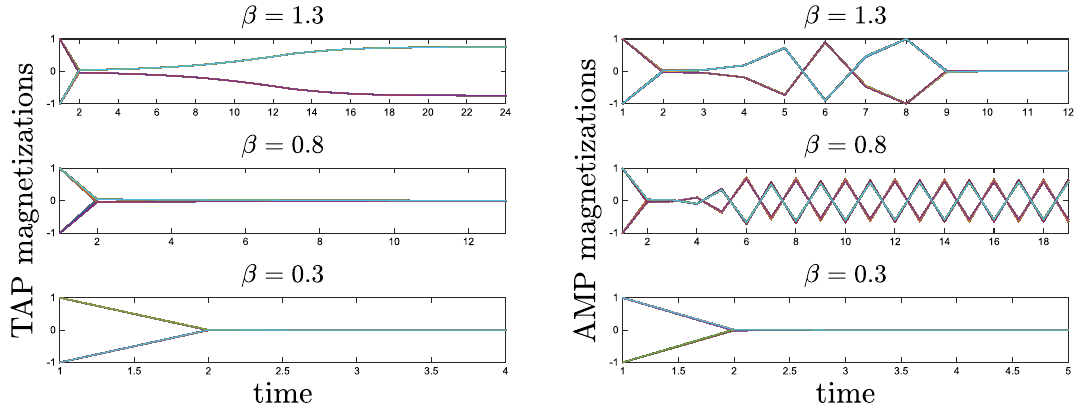
Figure 6. Trajectories of the N magnetizations m t i in the updating schemes of TAP, Eq. (7), and AMP, Eq. (8), 1000 , P 1 . Most of the trajectories are very similar, thus they are for three different temperatures at N = = 1 . The starting point is chosen at random with the absolute value indistinguishable. The critical value is at β = of the local magnetization equal to one. In the first steps, both TAP and AMP destroy the initial condition and 0 , AMP eqs. create very small magnetization values. Then, once close to the paramagnetic fixed point m = escape from it for β > 0.5 while TAP eqs. do not until β > 1 . Moreover, when leaving the paramagnetic state, the direction chosen by AMP is completely random, while TAP moves towards the